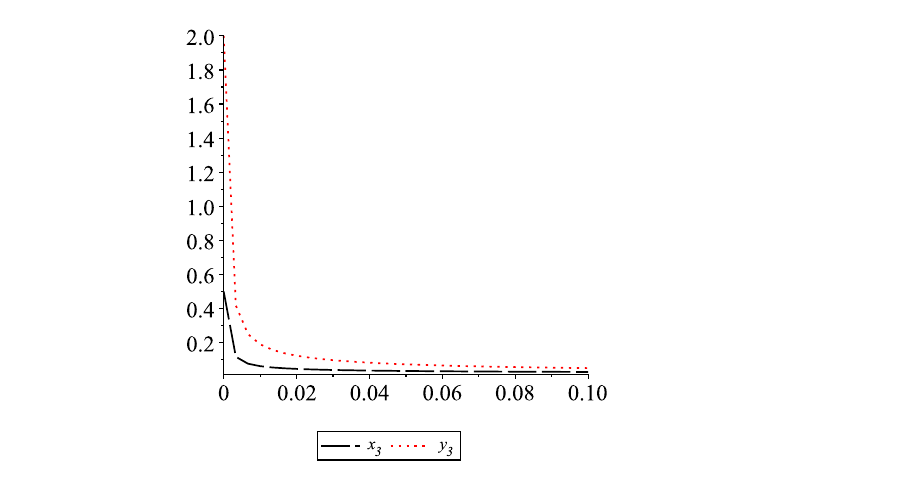
Figure 3: Graphs of third components of the solutions of both the slave and the master delay Caputo fractional system ( 21 ) , ( 20 )